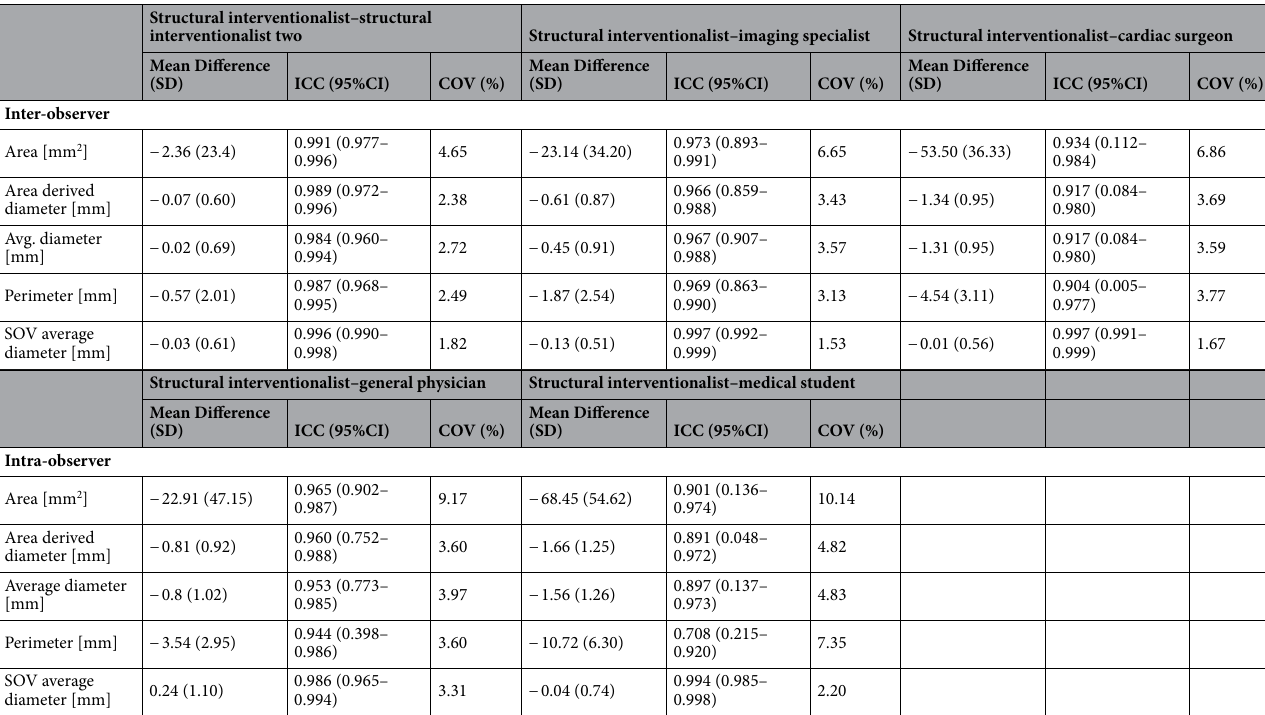
Table 6. Inter-observer agreement and reproducibility. Results are reported as mean (SD). SOV: sinus of valsalva; ICC: intraclass-correlation coefficient; CoV: coefficient of variation; SD: standard deviation; CI: confidence